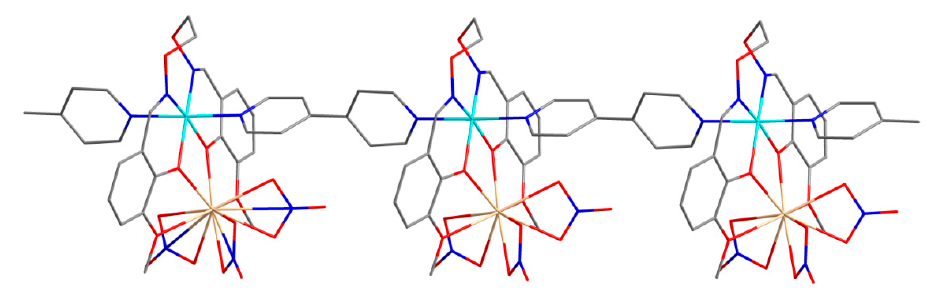
Figure 5. View of the intramolecular C–H··· π interactions.